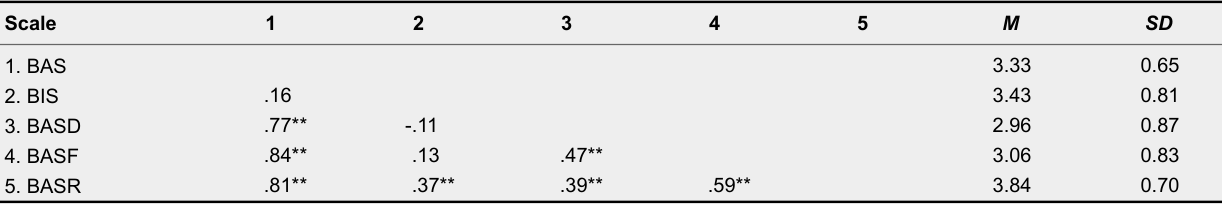
Correlations among the total BAS scale, the BIS scale, the BAS-drive subscale (BASD), the BAS-fun seeking subscale (BASF) and the BAS-reward responsiveness subscale